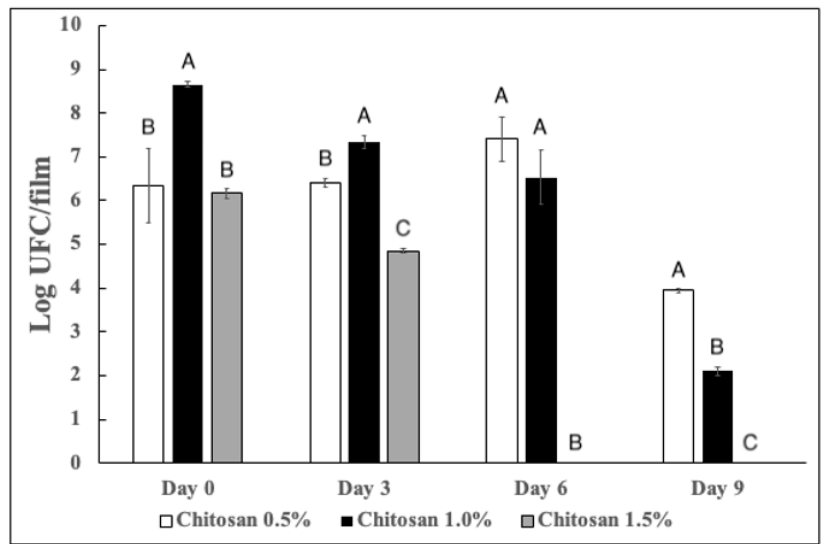
Figure 3. Population dynamics of D. hansenii entrapped in chitosan films. According to the LSD test, different letters indicate significant differences ( p < 0.05). Values are expressed as means ± standard deviation.